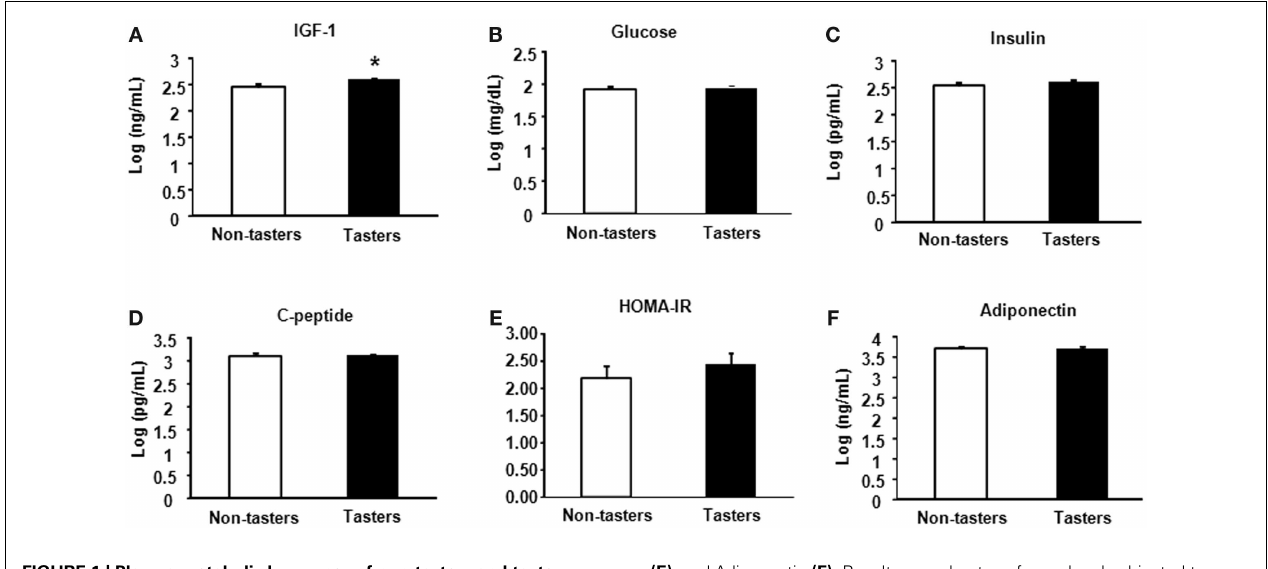
FIGURE 1 | Plasma metabolic hormones of non-tasters and tasters . Plasma samples from non-tasters and tasters were assayed to measure the levels of IGF-1 (A) , glucose (B) , insulin (C) , C-peptide (D) , HOMA-IR